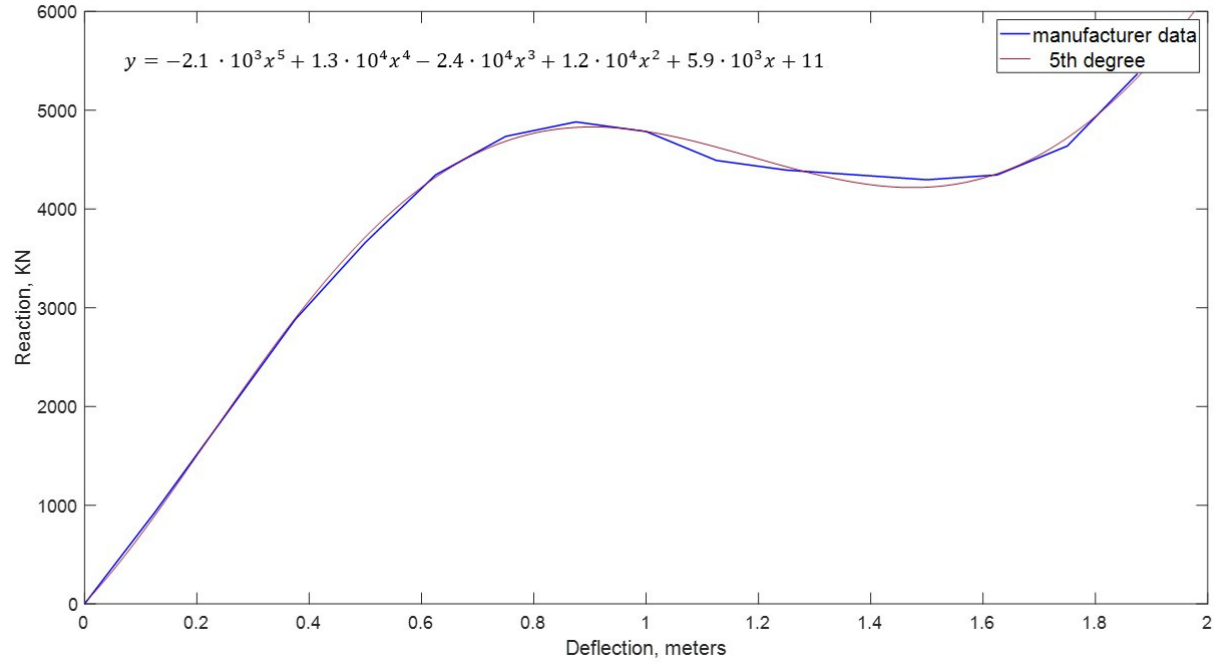
Figure 5. Stiffness curve of the SCN2500 F2.2 fender. The 5th degree polynomial was approximated via MATLAB.